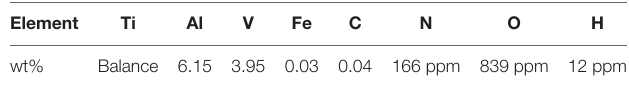
TABLE 1 | The chemical composition of Ti6Al4V powder.